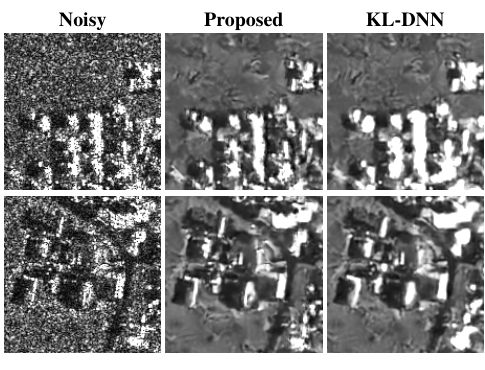
Figure 5. Details of real